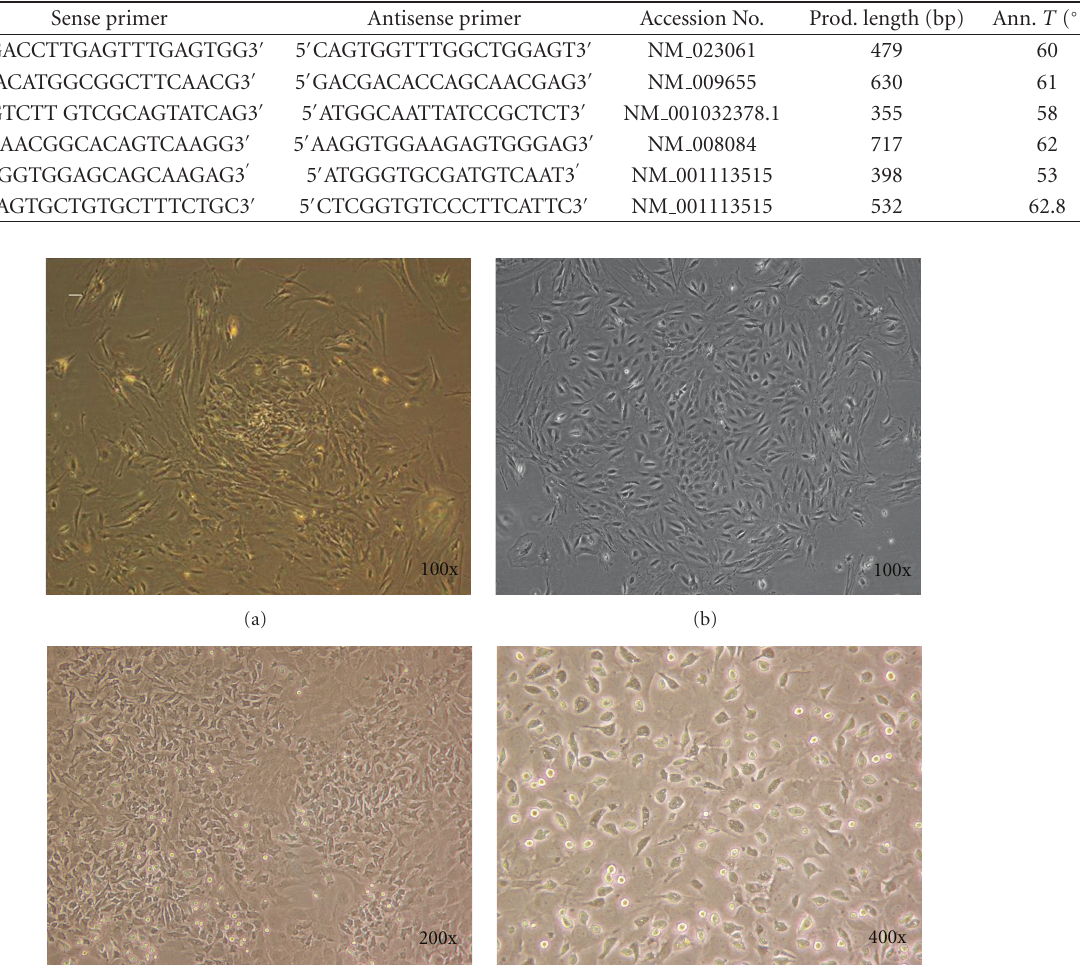
Table 1: Primes and the reaction conditions of RT-PCR.